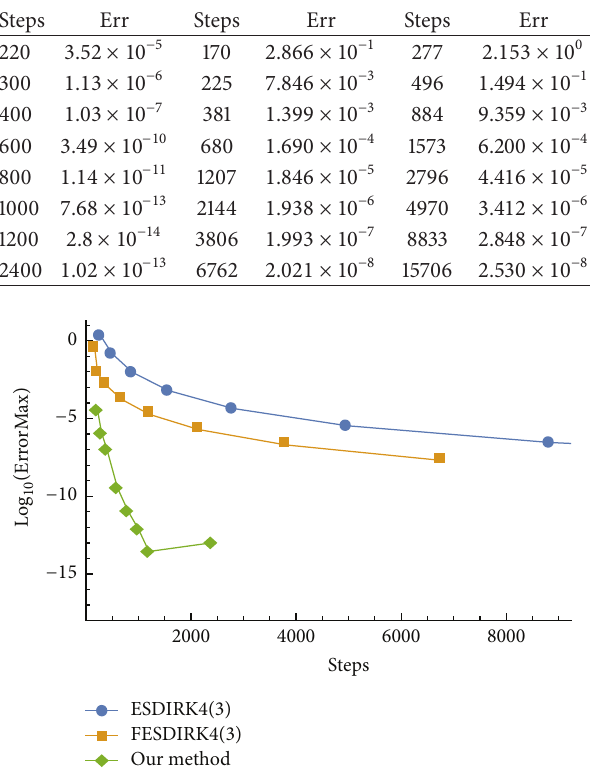
Figure 4: Efficiency curve for Example